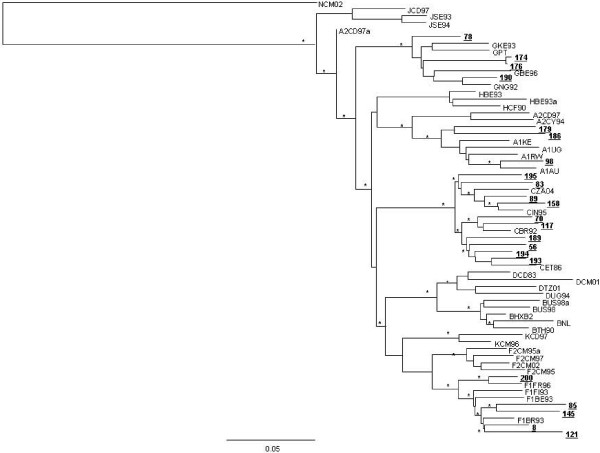
Phylogenetic relationships based on pol gene (1302 nt) of the HIV-1 pol gene between the HIV-1 non-B pure subtypes circulating in Italy (shown in bold and underlined) and representative strains of HIV-1 M group (subtypes A, C, D, F1, F2, G, H, J, K) from the Los Alamos HIV Sequence Database. The scale bar indicates 5% nucleotide sequence divergence.* indicates the P value < 0.001 (zero length branch test) and the bootstrap values more than 70%.